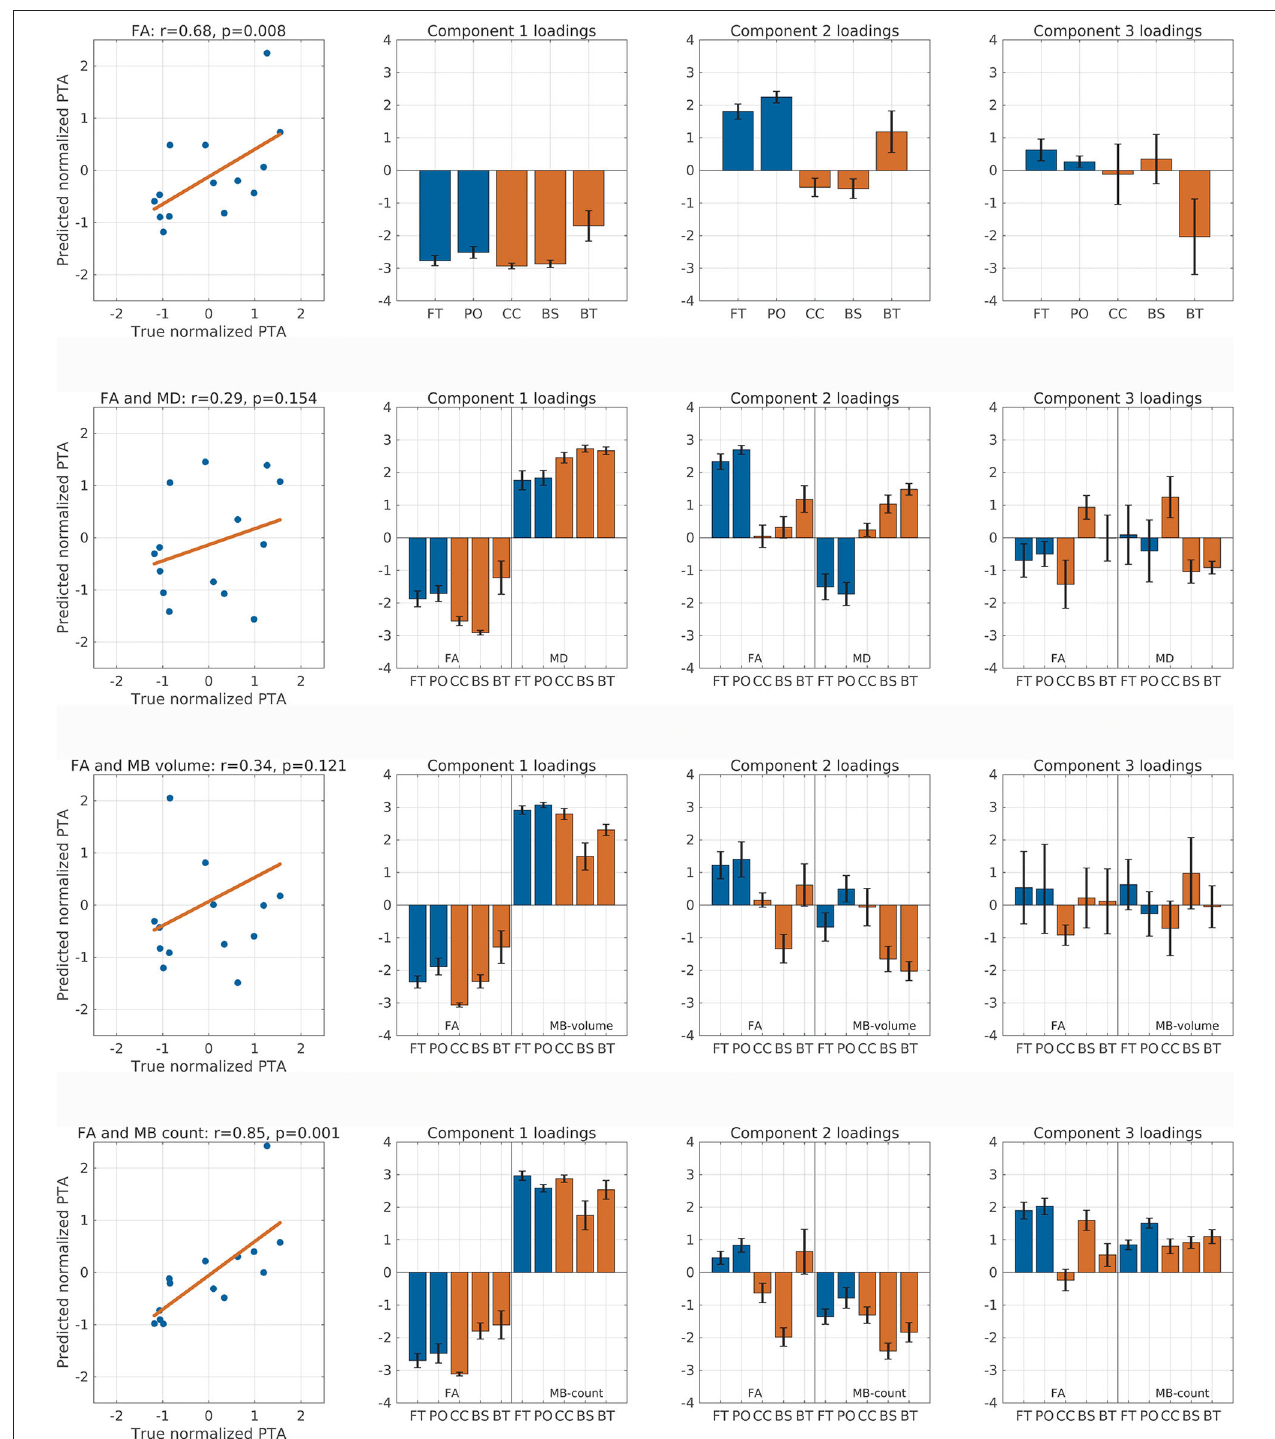
FIGURE 3 | Correlation between predicted and true post-traumatic amnesia (PTA) scores. This figure shows the correlation between predicted and true z score normalized PTA scores using partial least square regression with leave-one-out cross-validation. The rows represent analyses performed with fractional anisotropy (FA), FA and mean diffusion (MD), FA and micro bleed (MB) volume, and FA and MB count, respectively. The first column shows the correlation between true and predicted PTA scores and lists the Spearman correlation value as well as the permutation test p -value. Columns 2–4 show the component loadings for components 1–3, respectively. Red colored bars are the deep mesial brain regions, and the blue colored bars are the hemispheric brain regions. BS, brainstem (pons, midbrain, and medulla); BT, basal ganglia (caudate, putamen, and pallidum) and thalamus; CC, corpus callosum, cingular and subcingular white matter; FT, fronto-temporal region; PO, parieto-occipital